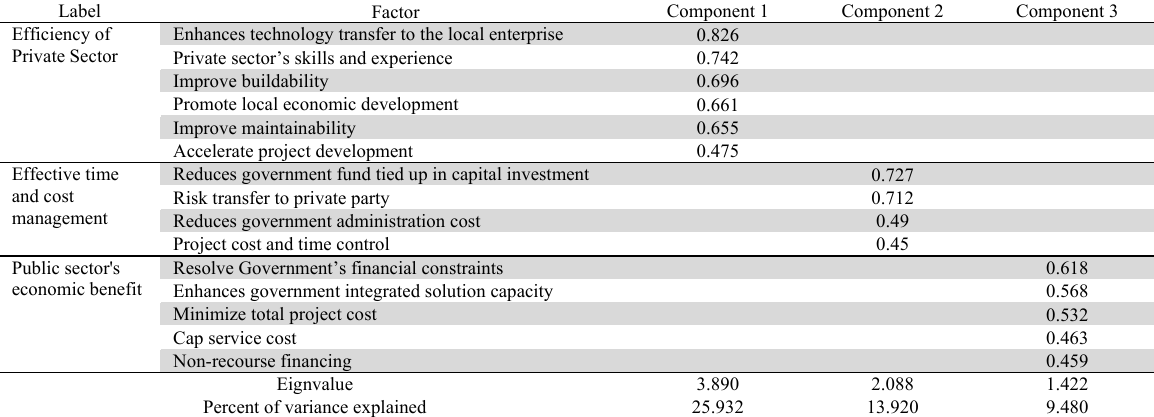
Grouping results after Rotated Component Matrix for attractive